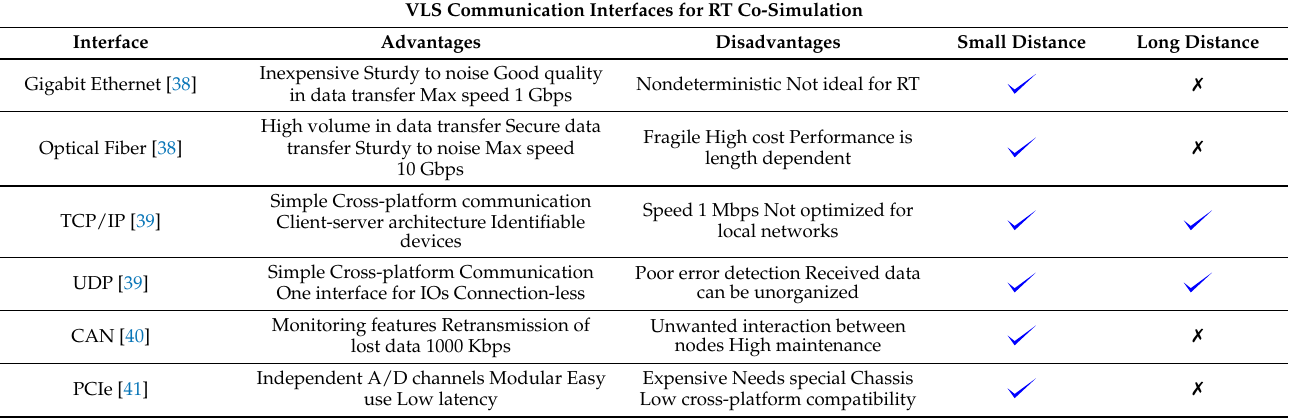
Table 3. Communication interface for RT VLS.